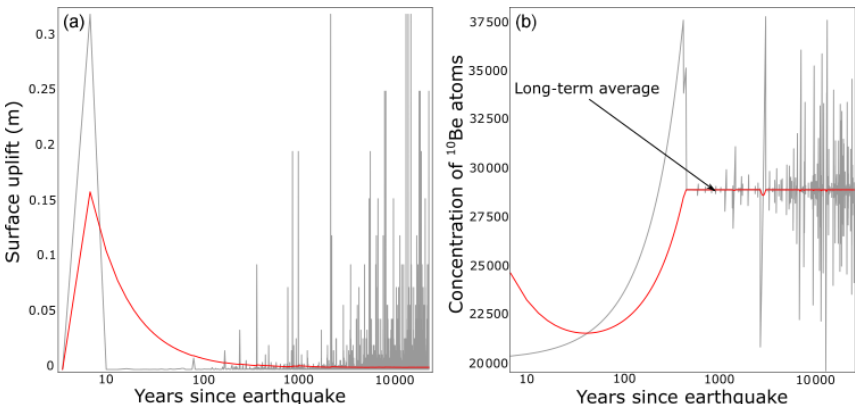
Figure 5. Variability of (a) topographic surface uplift and (b) the recorded concentration of cosmogenic nuclides leaving the orogen after a representative magnitude 8 earthquake within the model run. Red lines are the mean for the elapsed time since the earthquake, while the grey lines are the real-time